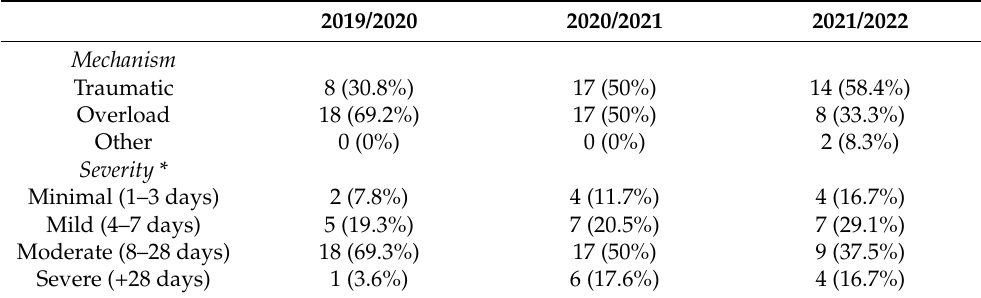
Table 4. Injury mechanism and severity during three consecutive sporting seasons.